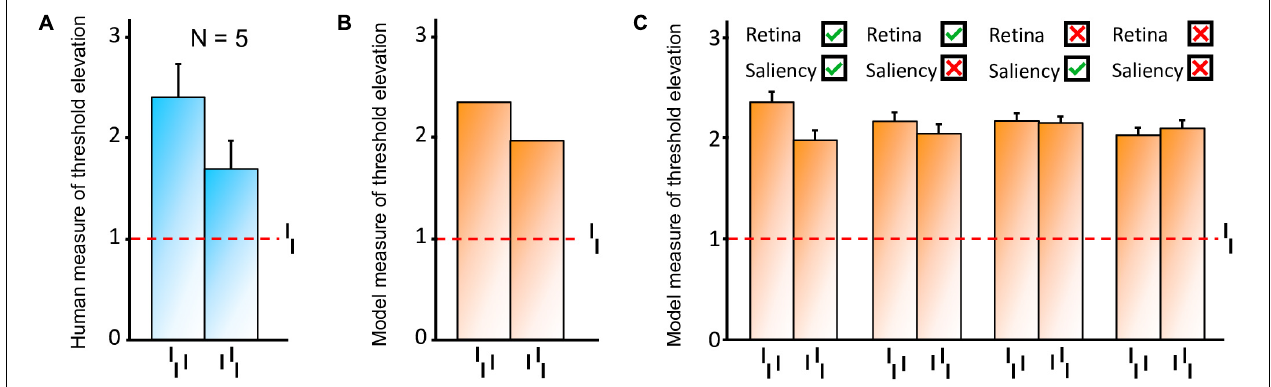
FIGURE 10 | Model results, reproducing the conditions of inward-outward anisotropy in experiment 1b of Manassi et al. (2012; see Figure 3A ). In each bar graph, the red dashed line shows the threshold for the unflanked condition (Vernier target alone). To compare the model with the data, we measured threshold elevation defined as the threshold of a condition divided by the threshold of the unflanked condition (see Methods section). (A) Behavioral data from experiment 1b in Manassi et al. (2012). (B) Simulation results obtained with the full visual system (retina, saliency, and segmentation). Contrary to the human data, we cannot compute error bars across observers because only a single set of model parameters is used in the simulations. The model fits the human data well, producing a similar anisotropy. (C) Comparison of the simulation results with and without the activation of the different modules of the visual system. Error bars were computed by simulating the system over 10 sessions (20 trials per session for each condition). When the retina model is inactive, the camera of the robot sends its signal directly to the segmentation model. When the saliency model is inactive, the selection signals are sent as they were in the original version of the segmentation model, i.e., sampling their location according a two-dimensional Gaussian distribution centered on the location that maximizes segmentation success. The best fit comes from the full visual system, and a bigger threshold elevation for the outer flanker condition, compared to the inner flanker condition, is generated only when the retina model is active.